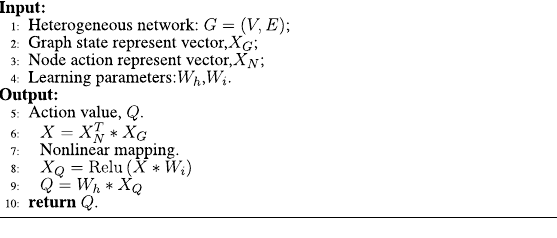
Algorithm 2. Heterogeneous network decoding.